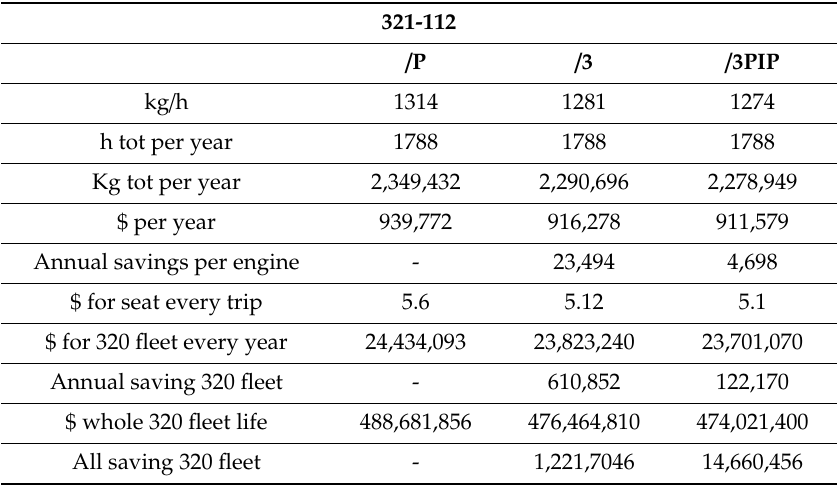
Table 3. Economic impact of upgrades in 321-112 engine.